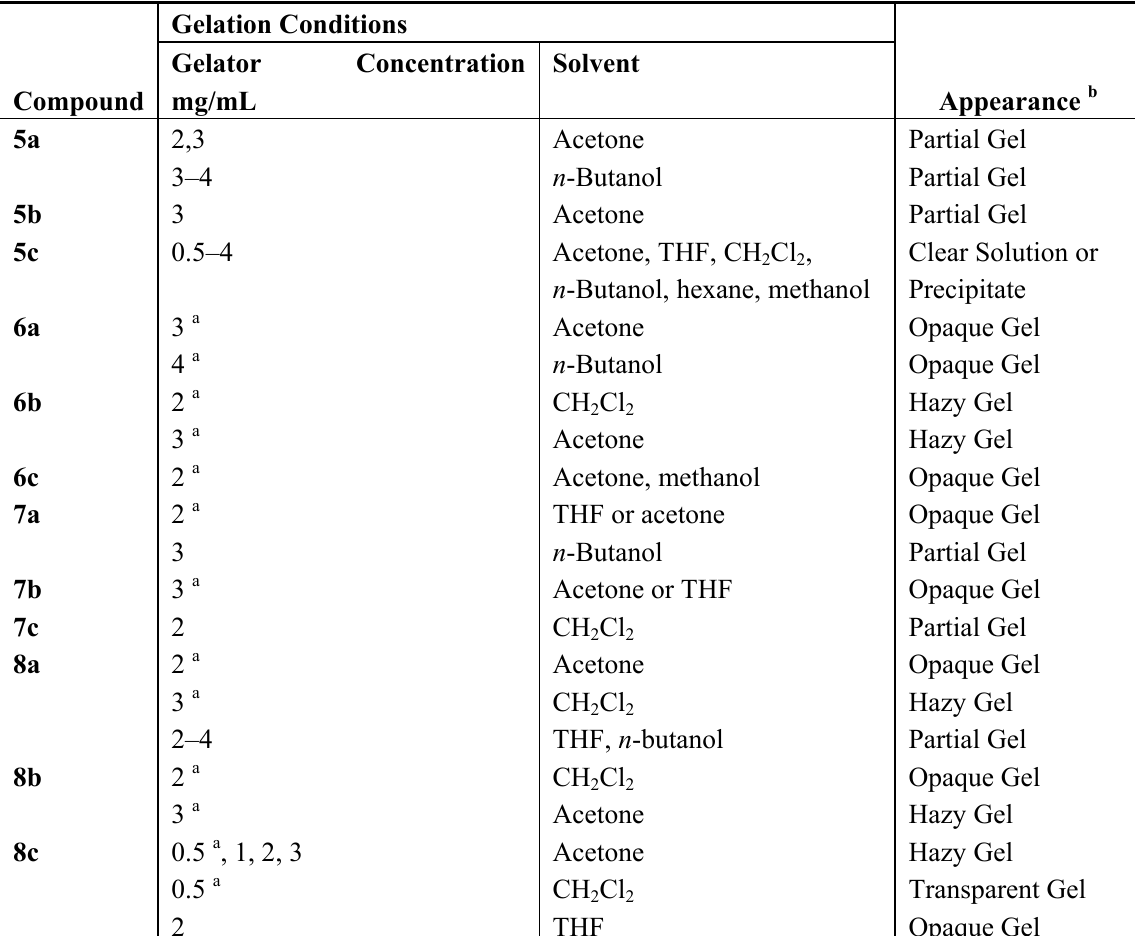
Table 1. Gelation properties of partially fluorinated amides ( 5a–c , 6a–c ) and urea-amides ( 7a–c , 8a–c